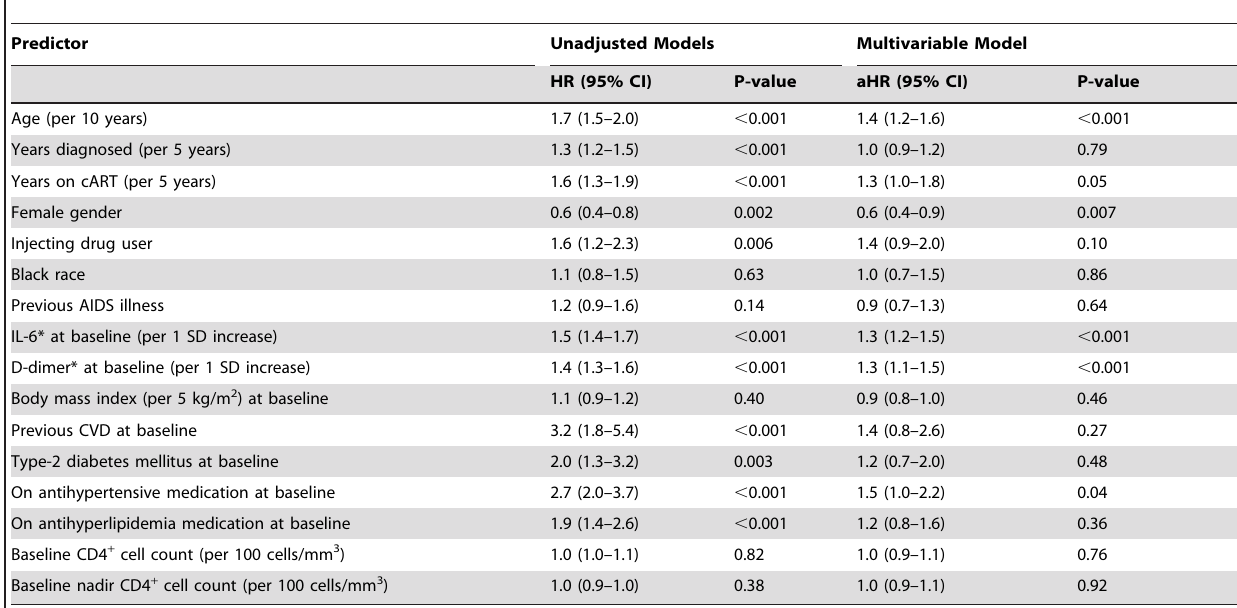
Table 4. Unadjusted and multivariable risk prediction models of composite endpoint of all-cause mortality, AIDS, and SNA events.